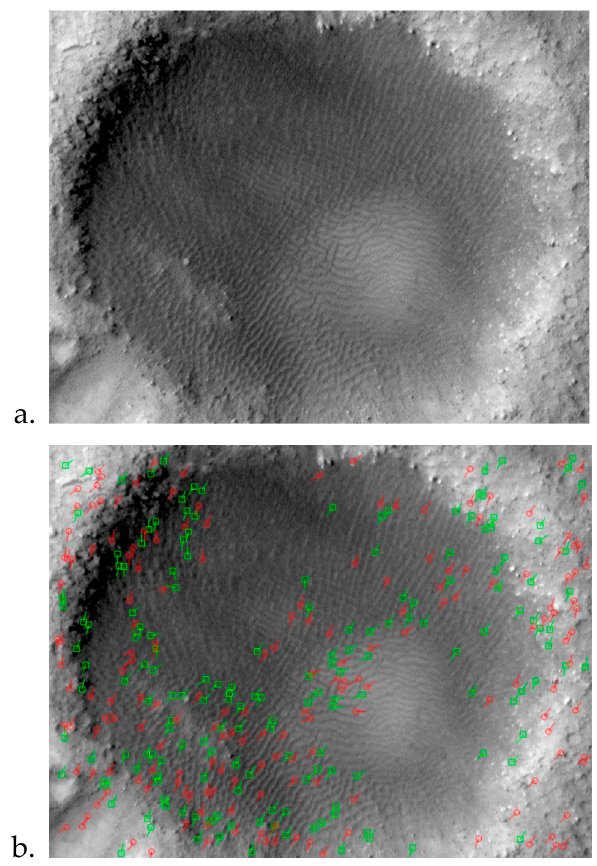
Figure 14. Site L188. (175.64, − 14.727 decimal degrees, − 258,319.587 m, − 872,801.8553 m, Projection GCS_Mars). ( a ) Raw image. ( b ) MINDTCT processed image. Color key same as Figure 10.